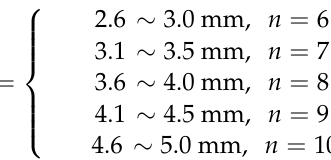
With the background gray value increase, the crack grayscale difference shows a trend of first increasing and then decreasing. When the background gray value reaches 140, it has the most significant difference, which is the best background gray value. 5. Result With the tunnel inspection vehicle, tunnel lining image acquisition was carried out in 66 highway tunnels in Zhejiang and Yunnan provinces, as shown in Figure 12. Figure 12. Tunnel inspection vehicle to carry out image collection ( a ) in the Shiziling tunnel, and ( b ) in the Zhaitouling tunnel. According to the tunnel inspection requirements, the hardware parameters of the camera system are determined by the experiment and theoretical analysis of the tunnel lining image acquisition system to realize the selection of shooting system hardware. Fur- thermore, the calculation method of shooting-related parameters zoom and focus value is formed, ensuring that the shooting parameters can be quickly calculated before entering the tunnel, by simply adjusting the aperture and starting tunnel image acquisition when in the tunnel. The typical tunnel lining crack images taken inside the tunnel are shown in Figure 13.